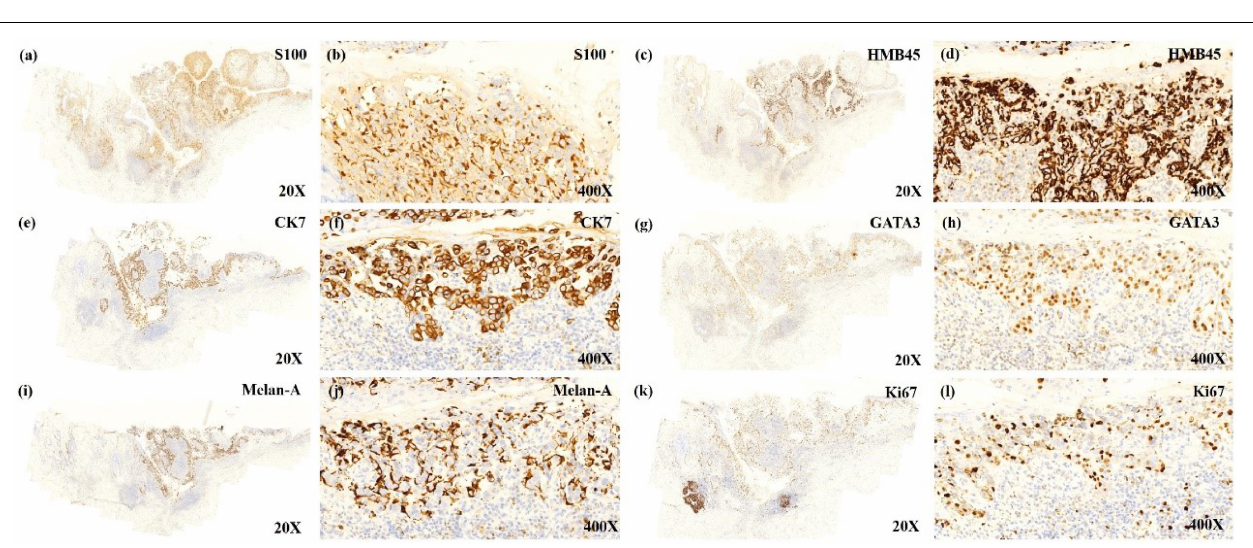
FIGURE 1 | (a) A little bit pigmentation on the overlying epidermis of the cut surface. (b) A low power view shows a tumor mass in the upper dermis. The tumor nests have infiltrated into the overlying epidermis. (c) Numerous single and small aggregations of atypical cells with large hyperchromatic nuclei and pale-staining cytoplasm throughout the epidermis. Melanin was observed within some tumor cells. (d) The invasive tumor cells were colonized on lactiferous ducts of the deep dermis.